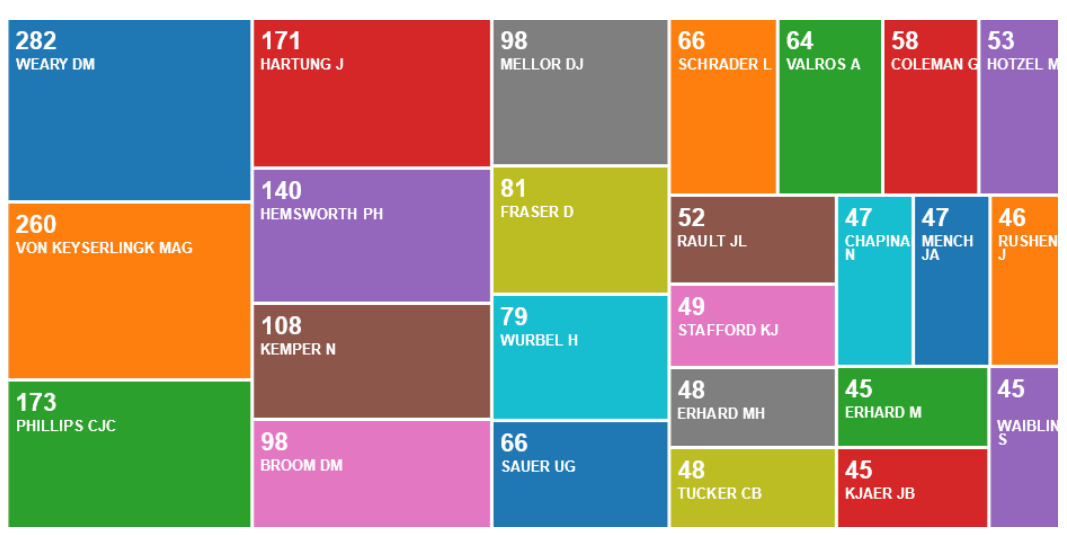
Figure 4. Number of publications per author, according to an online survey of publications by animal welfare centres in the Web of Science, May 2020.